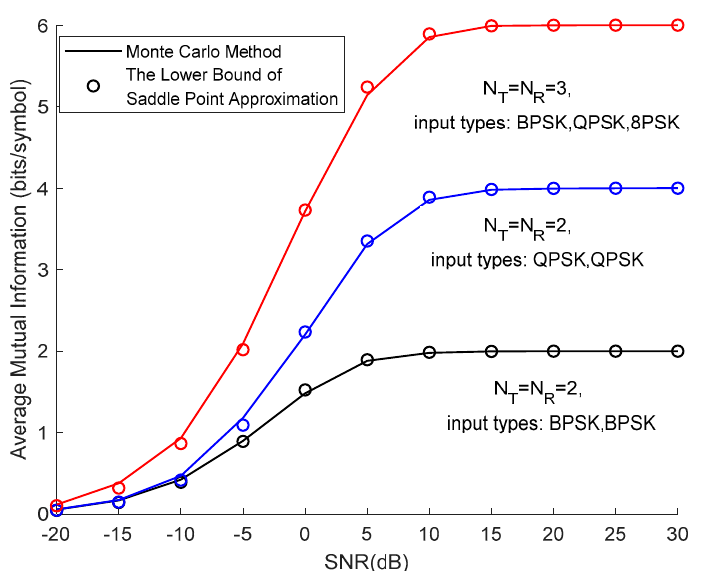
Figure 4. Comparison on MI calculated by Monte Carlo and the lower bound of saddle point approximation method under different input types and correction parameters ( ρ T = ρ R = 0.5) over doubly correlated Rayleigh fading channel